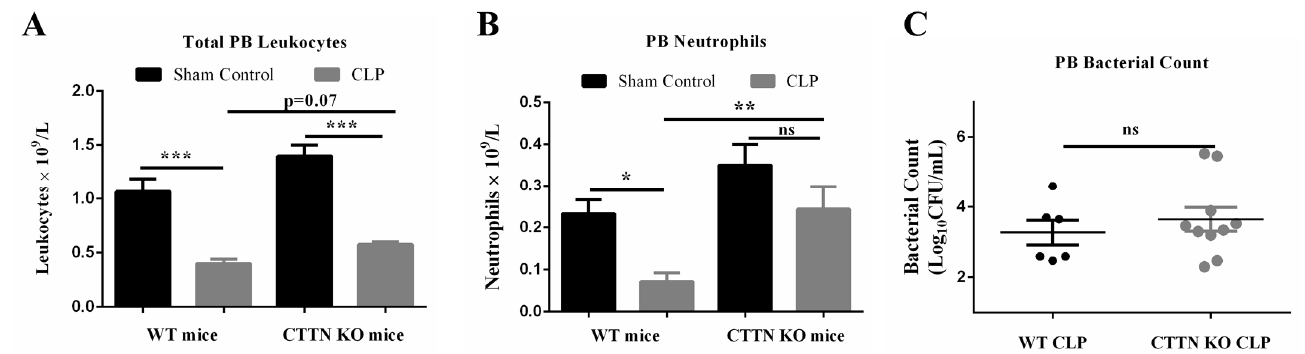
Figure 7. Neutropenia is prevented in septic cortactin-deficient mice. ( A ) Total leukocyte numbers and ( B ) neutrophil numbers in the peripheral blood 24 h after CLP or Sham surgeries in WT and cortactin-KO mice were determined using the automated HemaVet haematology analyser. ( C ) Bacterial CFU in the blood were determined by inoculation of serial dilutions on tryptic soy agar plates and counting CFU after 24 h incubation at 37 °C; dots represent the number of colony-forming units of PLF from independent mice. Data are represented as mean ± SEM. * p < 0.05, ** p < 0.01, *** p < 0.001. PB: Peripheral blood. CFU: colony-forming unit. ns: non-significant.